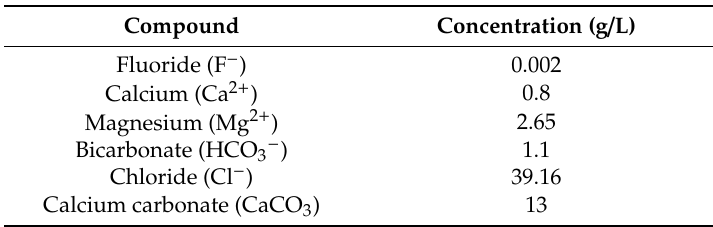
Table 3. Chemical composition of waste water.